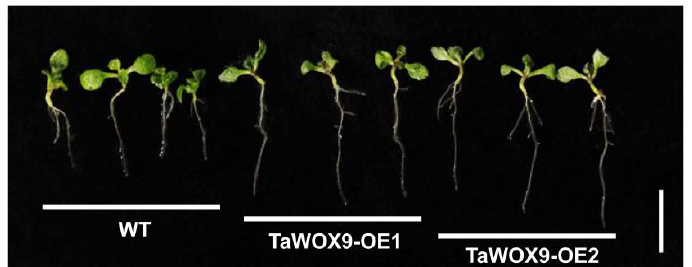
Figure 7. The root phenotype of overexpression of TaWOX9 (TaWOX9-OE) in Arabidopsis (10-day-old plants). Scale bar = 2 cm.